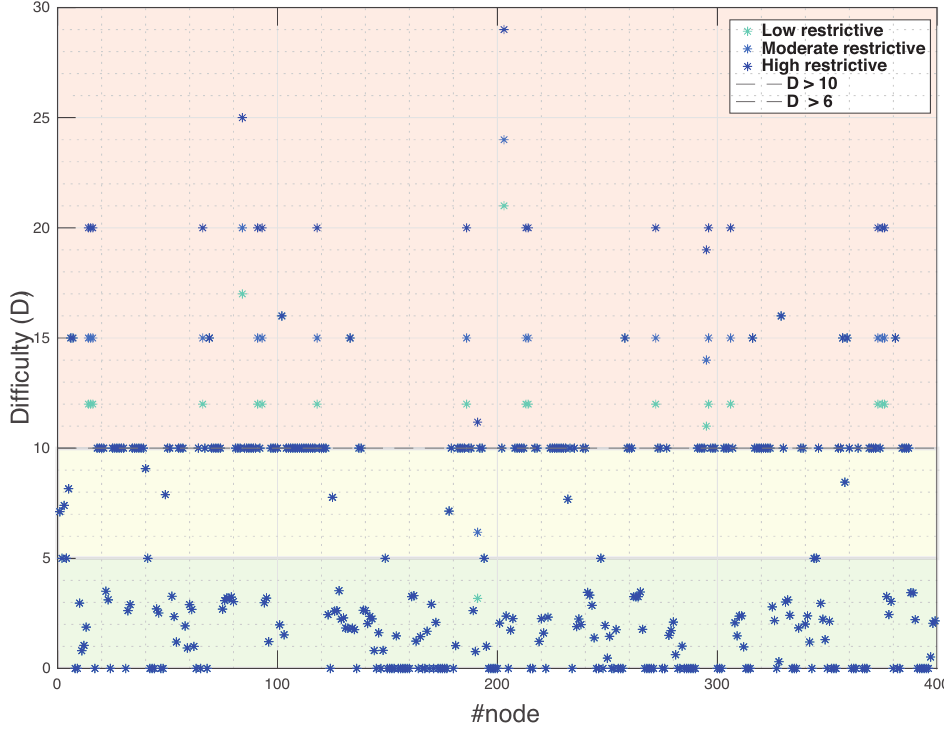
Figure 7. Difficulty values of the main streets of the city. The background color means the street accessibility levels for three different mobility